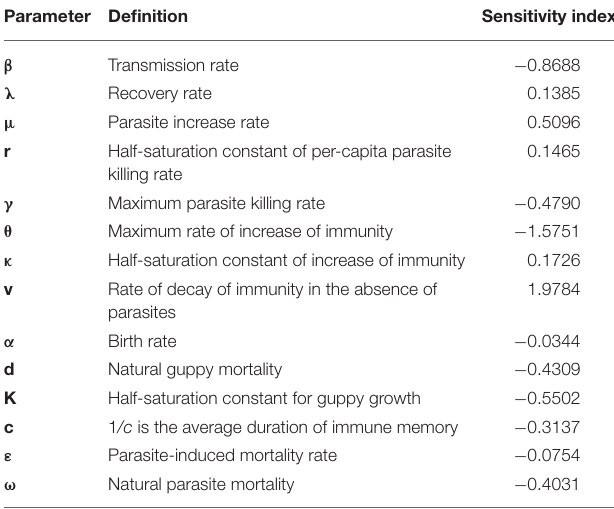
( Table 4 ). The guppy immune related parameters, θ (maximum rate of increase of immunity and v (rate of decay of immunity) have the strongest relationship to the outbreak peak. The negative value of the sensitivity of the outbreak to θ , indicates that a low value of θ will lead to a more severe parasite outbreak. The positive value of the sensitive